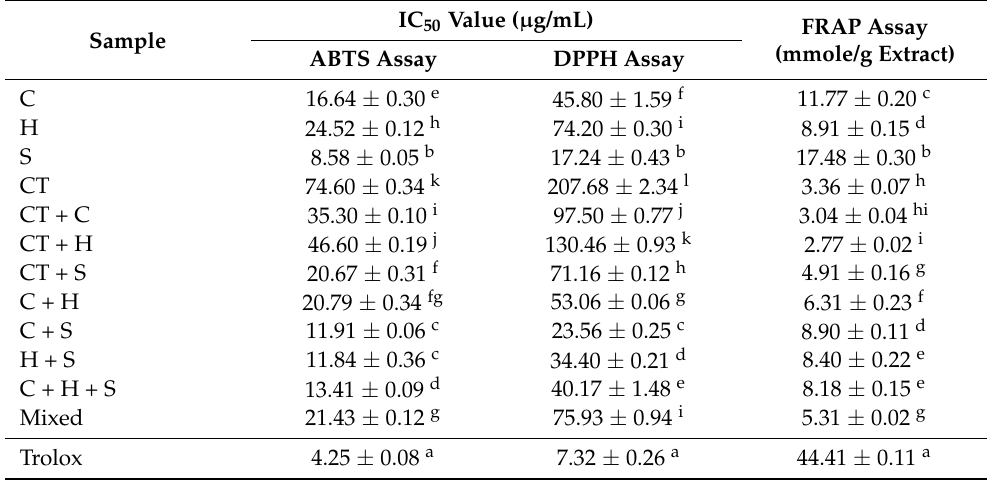
Table 3. Antioxidant capacities of combined extracts obtained from purple corns and butterfly peas.